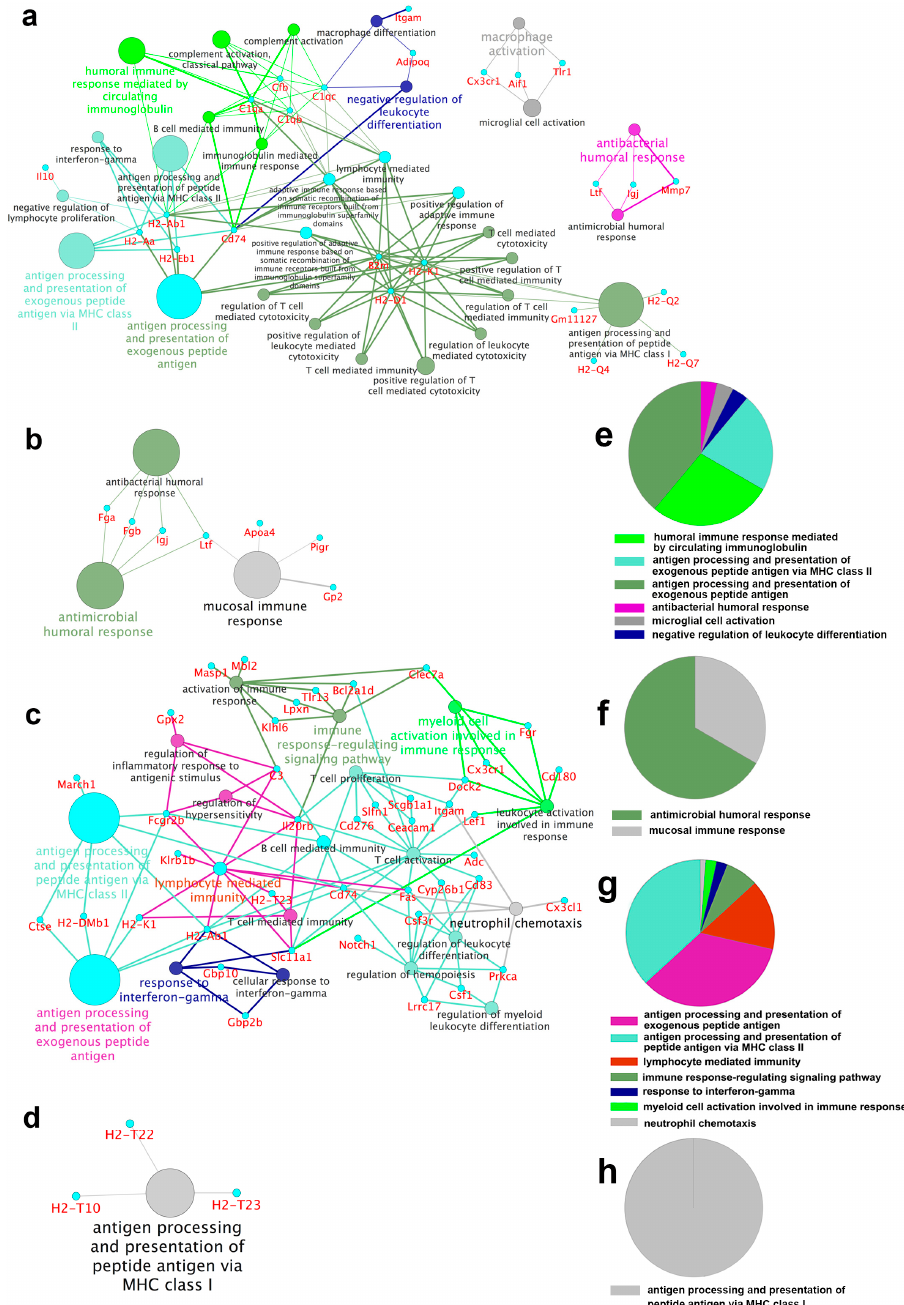
Figure 3. Functionally grouped annotation in immune system process. Annotation network and overview chart indicating functional groups in immune system processes are analyzed using ClueGo. Nodes are the terms of the functionally grouped network. The sizes of nodes represent the term enrichment significance. The groups are visualized with different colors on the network. Groups with related functions partially overlap. ( a , e ) DEGs in WT mice (CpG ODN vs. control ODN); ( b , f ) DEGs in NOD mice (CpG ODN vs. control ODN); ( c , g ) DEGs between WT and NOD mice on CpG ODN treatment; and ( d , h ) DEGs between WT and NOD mice on control ODN treatment.